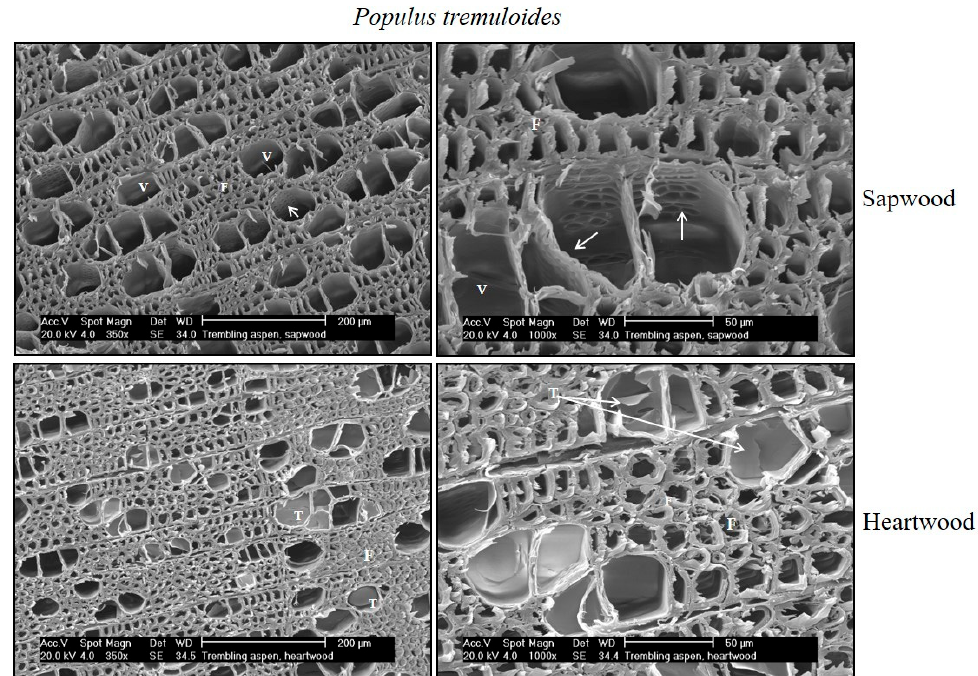
Figure 3. Scanning electron micrographs of Populus tremuloides stem tissues. On the right, micrographs are at a scale of 200 μ m. Micrographs on the right are at higher magnification (50 μ m). The sapwood micrographs show the vessels (V) and fibers (F), and arrows show the lateral pitting between vessels. The heartwood vessels (T) do not conduct sap anymore since they are sealed by tyloses.